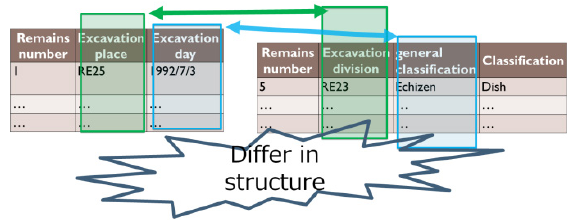
Fig. 1. An example of the different structures of information